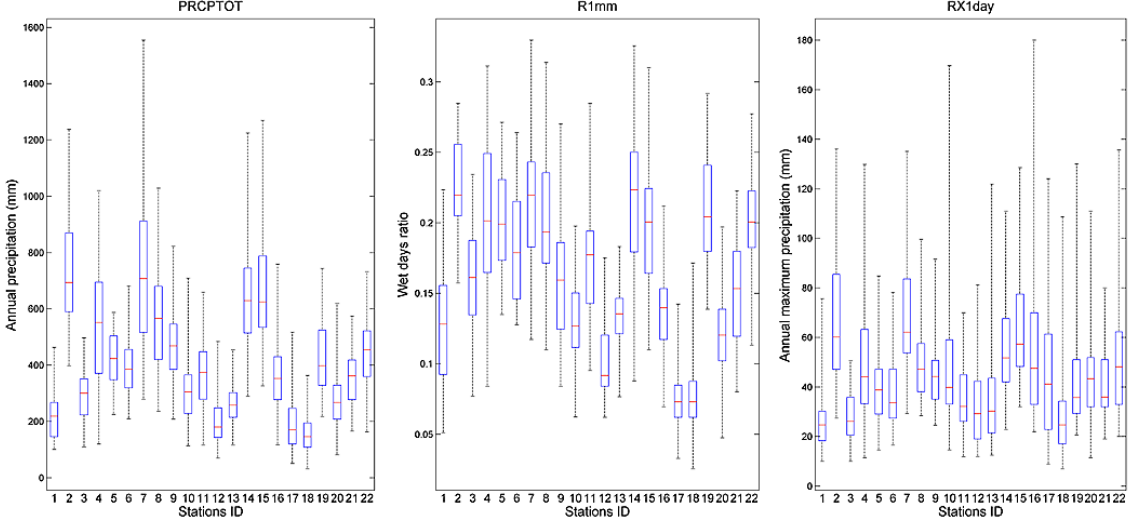
Fig. 4. Box plots showing the PRCPTOT, R1mm and RX1day precipitation indices for the 22 rain gauges considered in this study. The boxes have lines at the lower quartile, median and upper quartile values; the whiskers extend from each end to the most extreme values. The ID and name of the stations are reported in Table